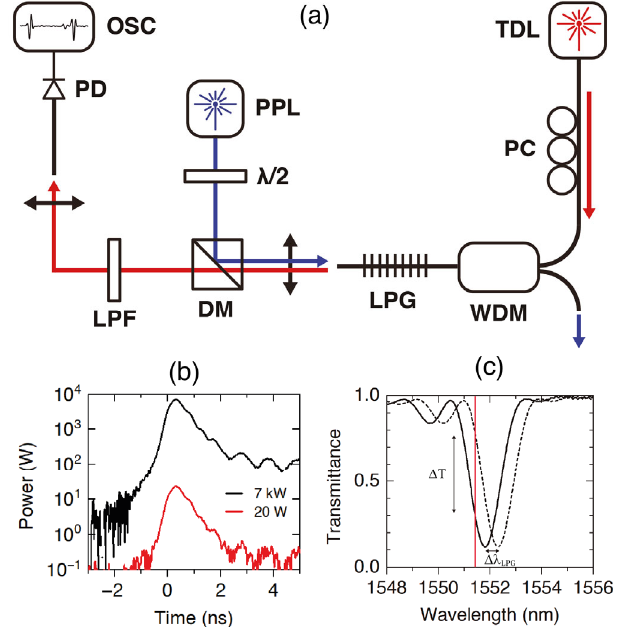
Figure 1. ( a ) Experimental setup. OSC: oscilloscope; PD: fast photodetector; LPF: long-pass filter; DM: dichroic mirror; WDM: wavelength division multiplexer; PPL: pulsed pump laser; λ /2: half wavelength plate; TDL: tunable continuous wave diode laser; PC: polarization controller; Blue line: pump laser path; Red line: probe laser path. ( b ) Typical pump pulses for 7 kW and 20 W peak powers. ( c ) Transmittance of the LPG and operation principle of the pump and probe technique: (i) the vertical dashed line indicates the probe laser wavelength, which is set in the linear region of the LPG transmittance, and (ii) the acoustic wave will shift the resonance wavelength of the grating ( ∆ λ LPG ) and this will cause the transmission of the probe signal to be modulated by ∆ T